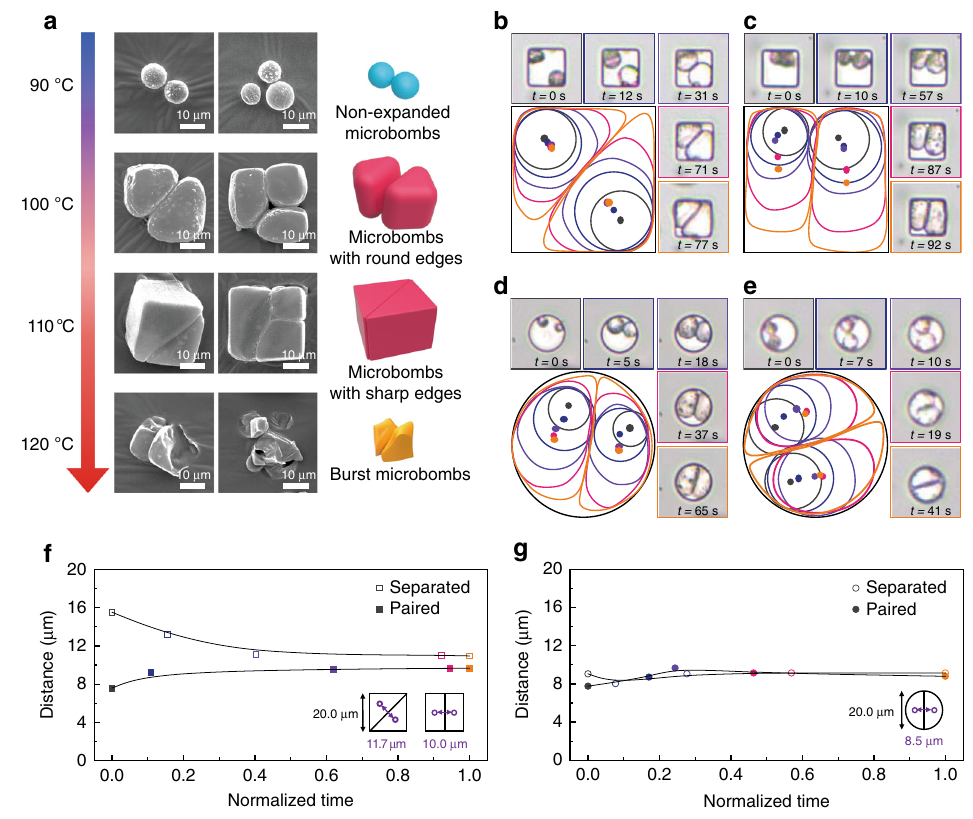
Fig. 4 Real-time tracking of the micro-cluster formation. a SEM images and the corresponding illustrations of the clusters formed at different temperatures. b , c Optical images and corresponding illustrations of the trajectories of a pair of microbombs that are separated ( b ) and paired ( c ) upon explosion in square con fi nement. d , e Optical images and the corresponding illustrations of circular con fi nement of two separated ( d ) and paired ( e ) microbombs. f , g Plots of center-to-center distances between two constituent cells as a function of time normalized by the time required to reach the convergent center- to-center distance within square ( f ) and circular ( g ) con fi